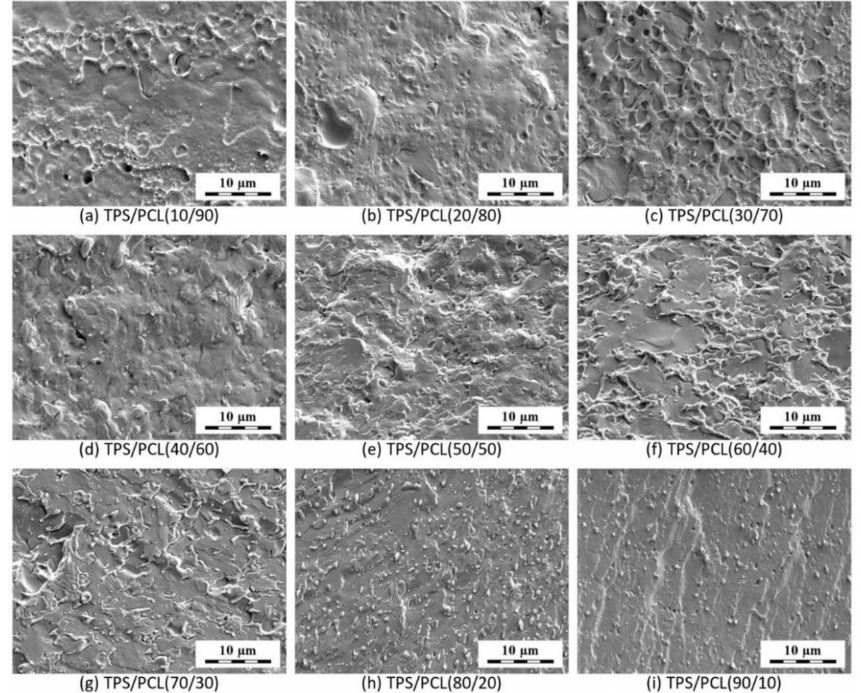
Figure A4. SEM micrographs of fracture surfaces of TPS/PCL blends. The materials were fractured while submerged in liquid nitrogen. The micrographs demonstrate that the fracture propagated mostly through both phases (and not along the interface), which indicates good interfacial adhesion between TPS and PCL components.